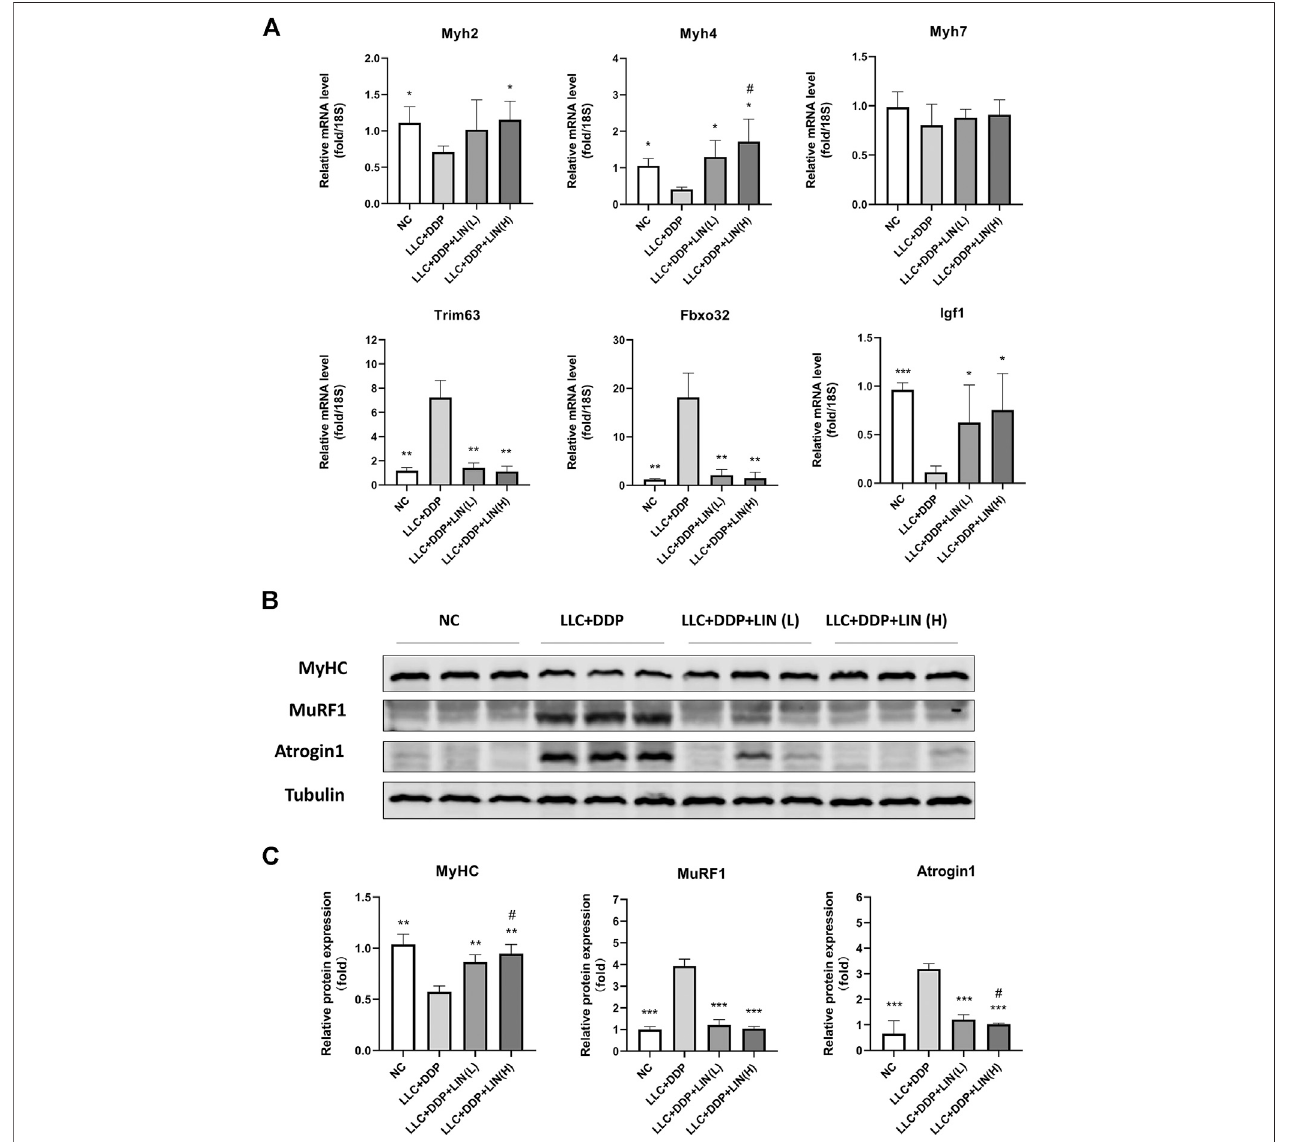
FIGURE3| LINupregulatedtheexpression ofmyogenesis related factors inGAmuscleand down regulatedtheexpression ofmuscledegradation related factors (A) ThemRNAexpressionofMyh2,4,7,Trim63,Fbxo32,Igf1intheGAmusclewasassessedbyqRT-PCR,18Swasusedasaninternalcontrol. (B) Proteinexpression of MyHC, MuRF1, Atrogin1 was evaluated by western blotting, Tubulin was used as an internal control. (C) The relative expression levels of the proteins were quanti fi ed using ImageJ software and normalized to Tubulin and corrected to Group NC. Data shown as mean ± S.E.M. (n (cid:2) 3); * p < 0.05, ** p < 0.01, *** p < 0.001 vs. Group LLC + DDP, # p < 0.05 vs. Group LLC + DDP + LIN(L).